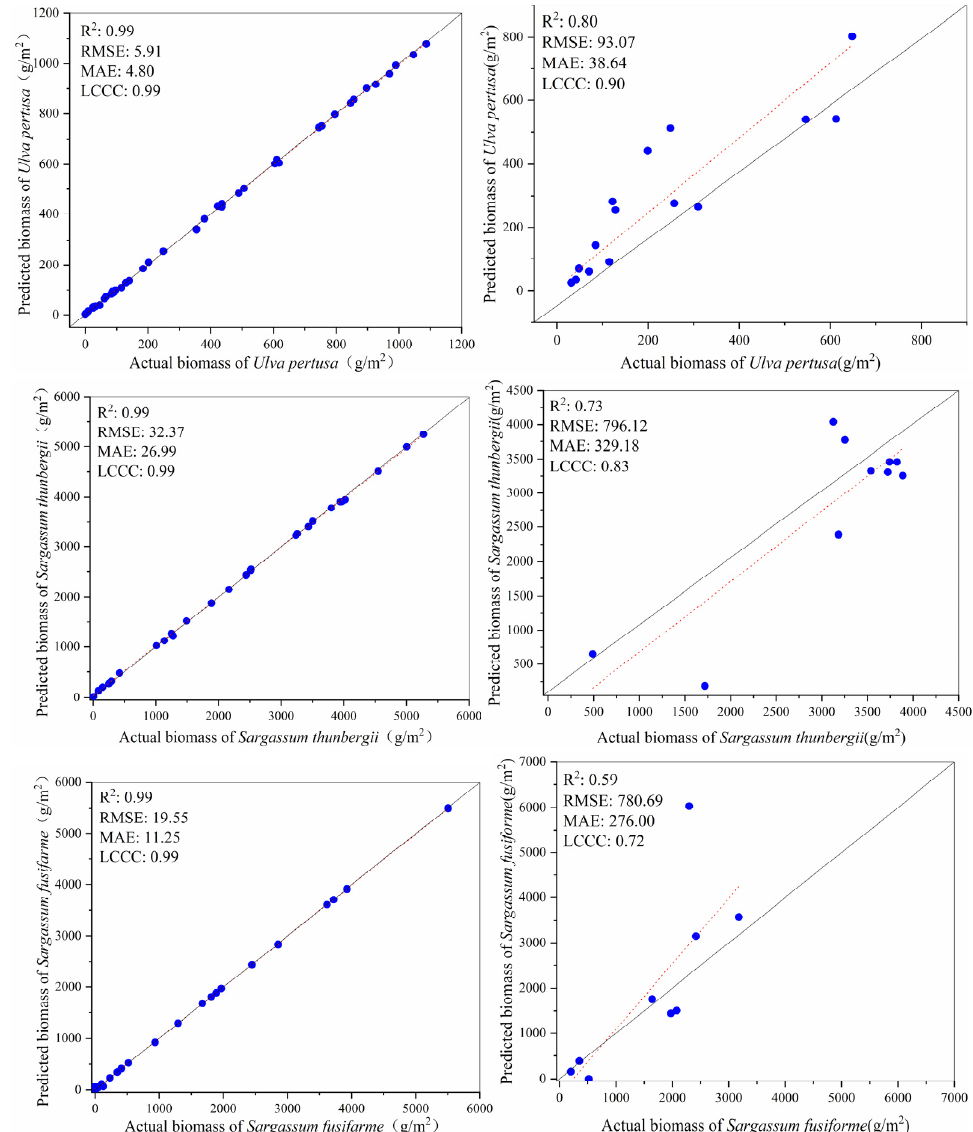
Figure 10. Prediction indices calculated by GBDT.